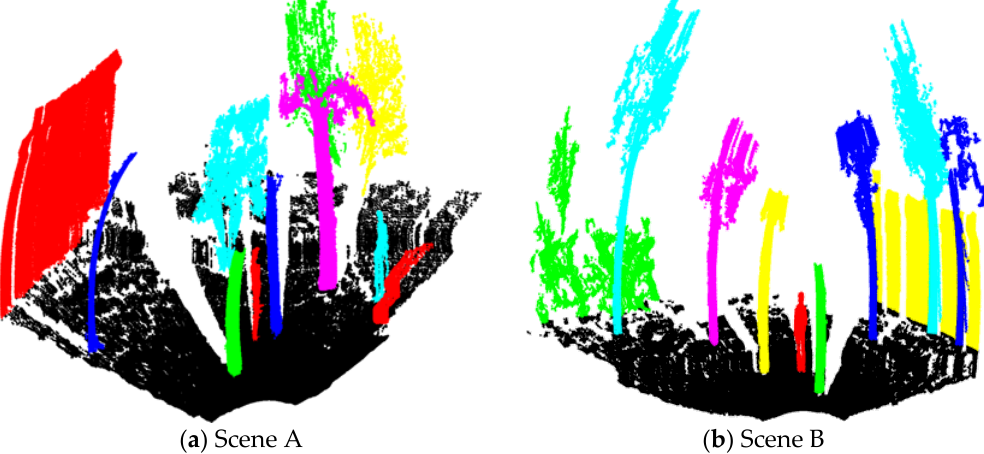
Figure 12. Semantic segmentation of independent objects in Scene A ( a ) and Scene B ( b ).